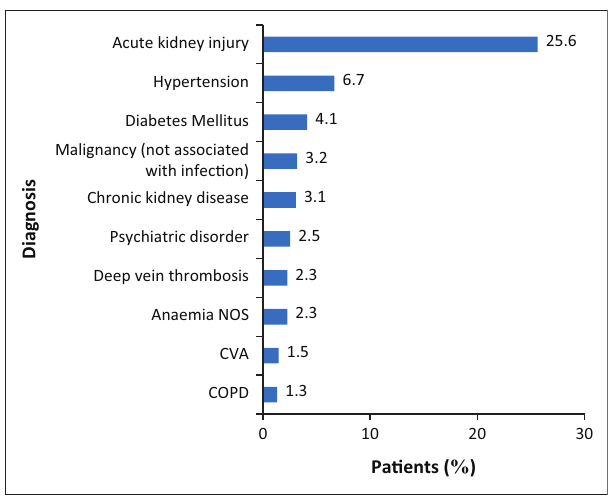
FIGURE 4: Top 10 non-infectious co-morbidities made in individual patients seen by infectious diseases department at Helen Joseph Hospital during October 2015 – March